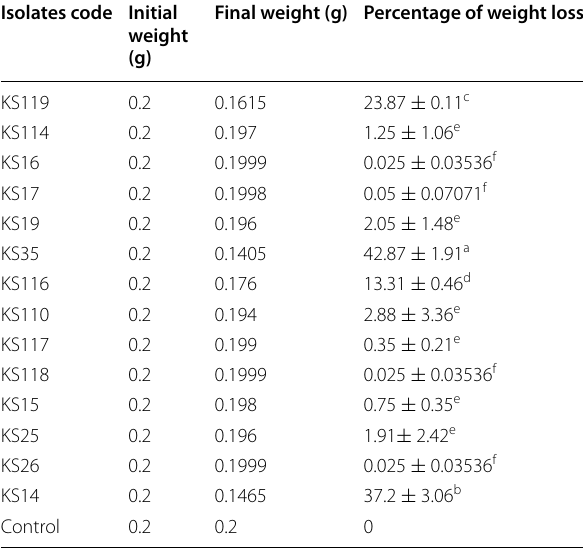
standard deviation) ±